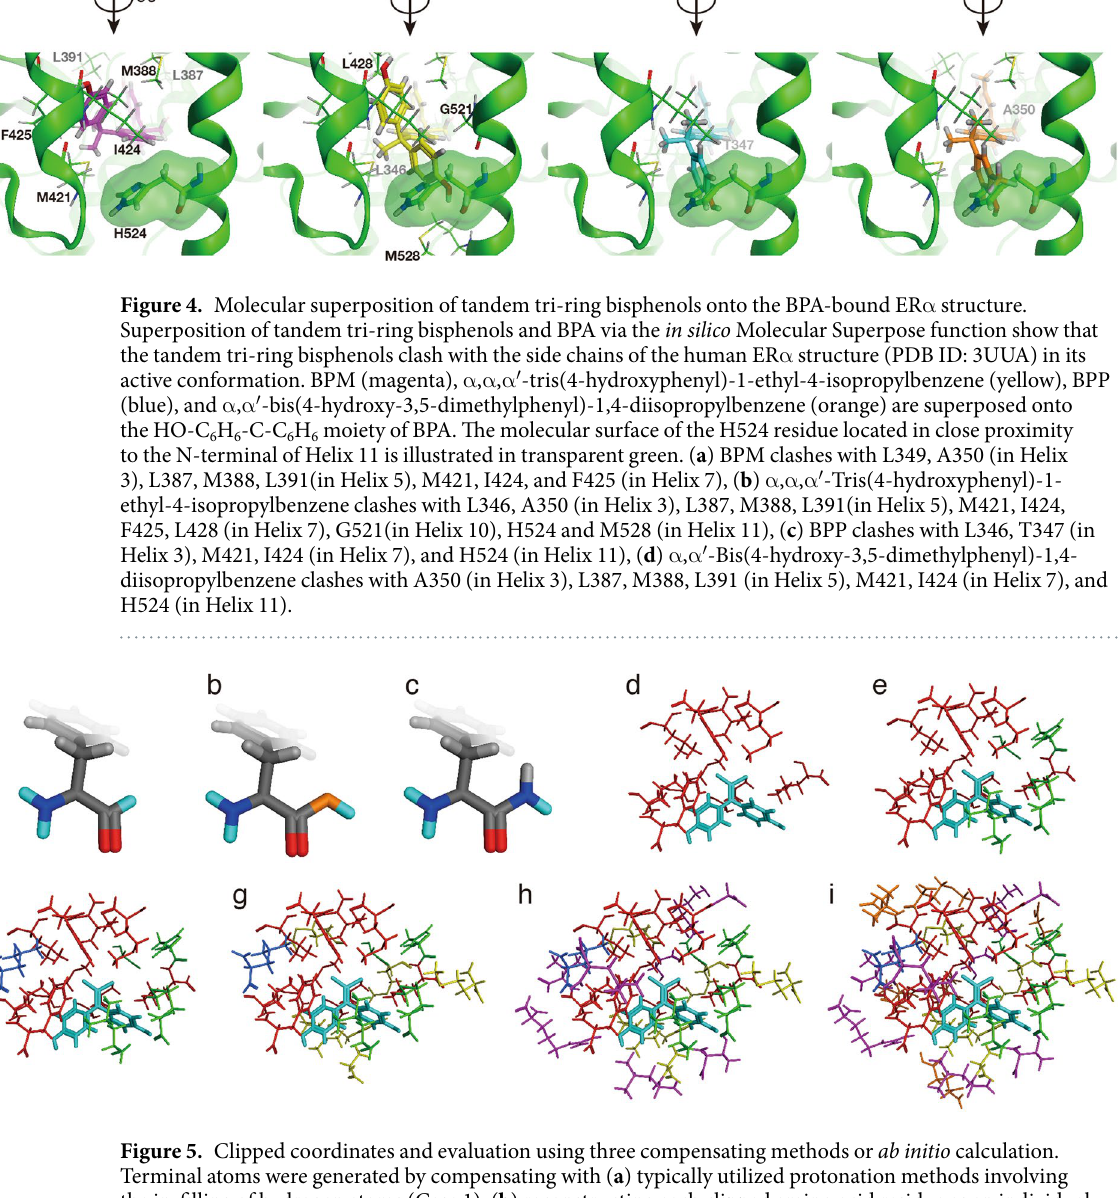
bound to ER α with high affinity. Common methods used for ab initio analysis of large biomolecules include frag- mentation methods 35,36 , although improved systematic fragmentation methods are required. Our results of the ab initio calculation of the ER α –BPC complex indicated that the novel HIVE clip method described in this study was beneficial for evaluating the ligand-bound conformation of the large biomolecules. Previous studies reported the binding affinities of bisphenol derivatives using competitive binding assay 37–40 , and screening experiments for ER α− related transcriptional activity of ER α were commonly performed using reporter-gene assays. Two studies analysed the transcriptional activities of structurally related BPA derivatives as ER α agonists, with 19 and 55 compounds systematically examined, respectively, although these included neither